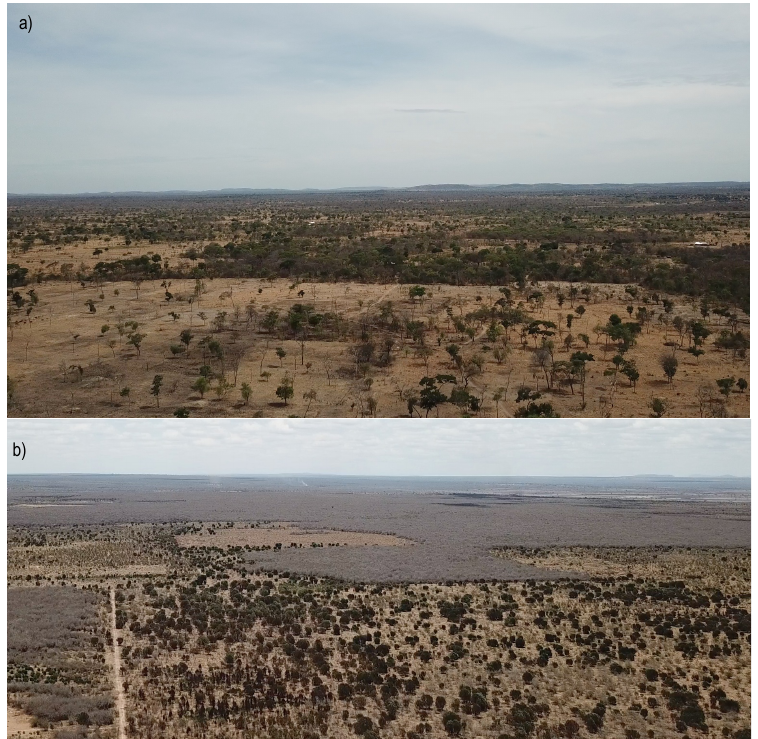
Figure 11. Aerial view of fragmented forest landscape based on drone capture for savanna woodland at ( a ) Igombe river forest reserve and ( b ) Itigi thicket, October 2019 (photos acquired by